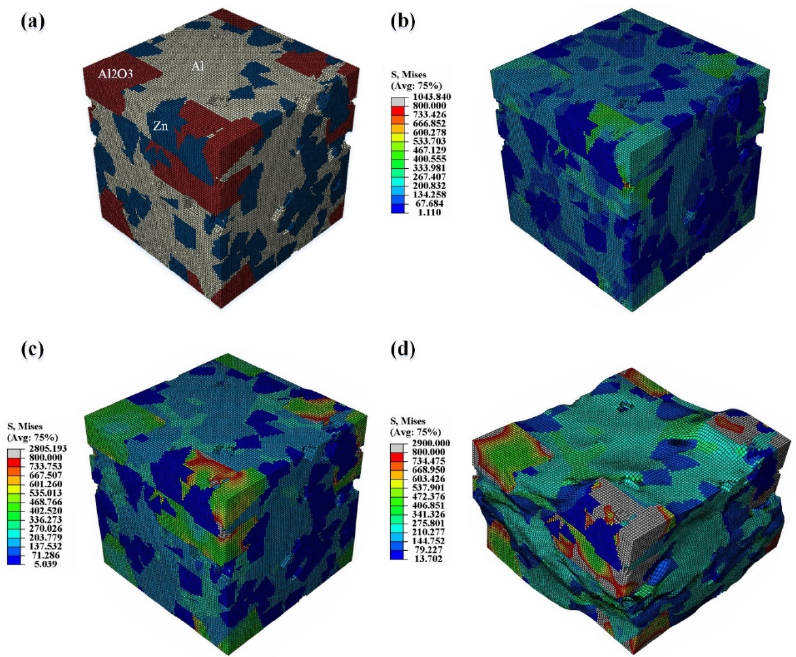
Figure 11. The von Mises stress distribution of microscopic model under different strain loads: ( a ) the original model; ( b ) ε z = 0.003; ( c ) ε z = 0.03; ( d ) ε z = 0.3.